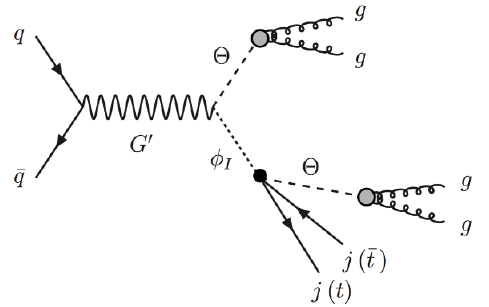
Figure 9 . Resonant production of a coloron that decays into an octet scalar (cid:2) and a singlet scalar (cid:30) I , which then decays (for M (cid:2) < M (cid:30) ) via an o(cid:11)-shell coloron into a (cid:2) plus either two quark jets I or t (cid:22) t